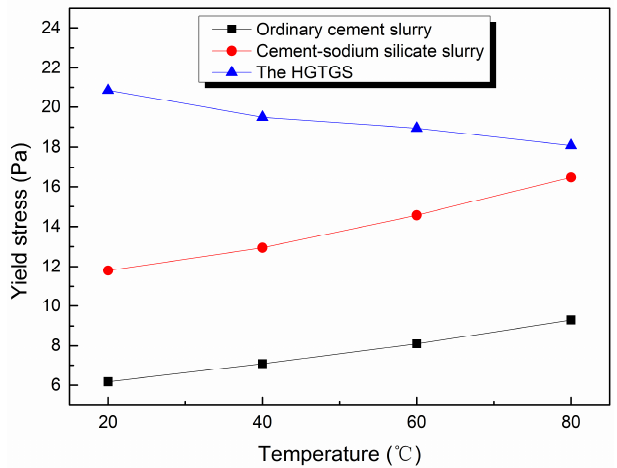
Figure 16. The variation of yield stress of different types of slurries with temperature.